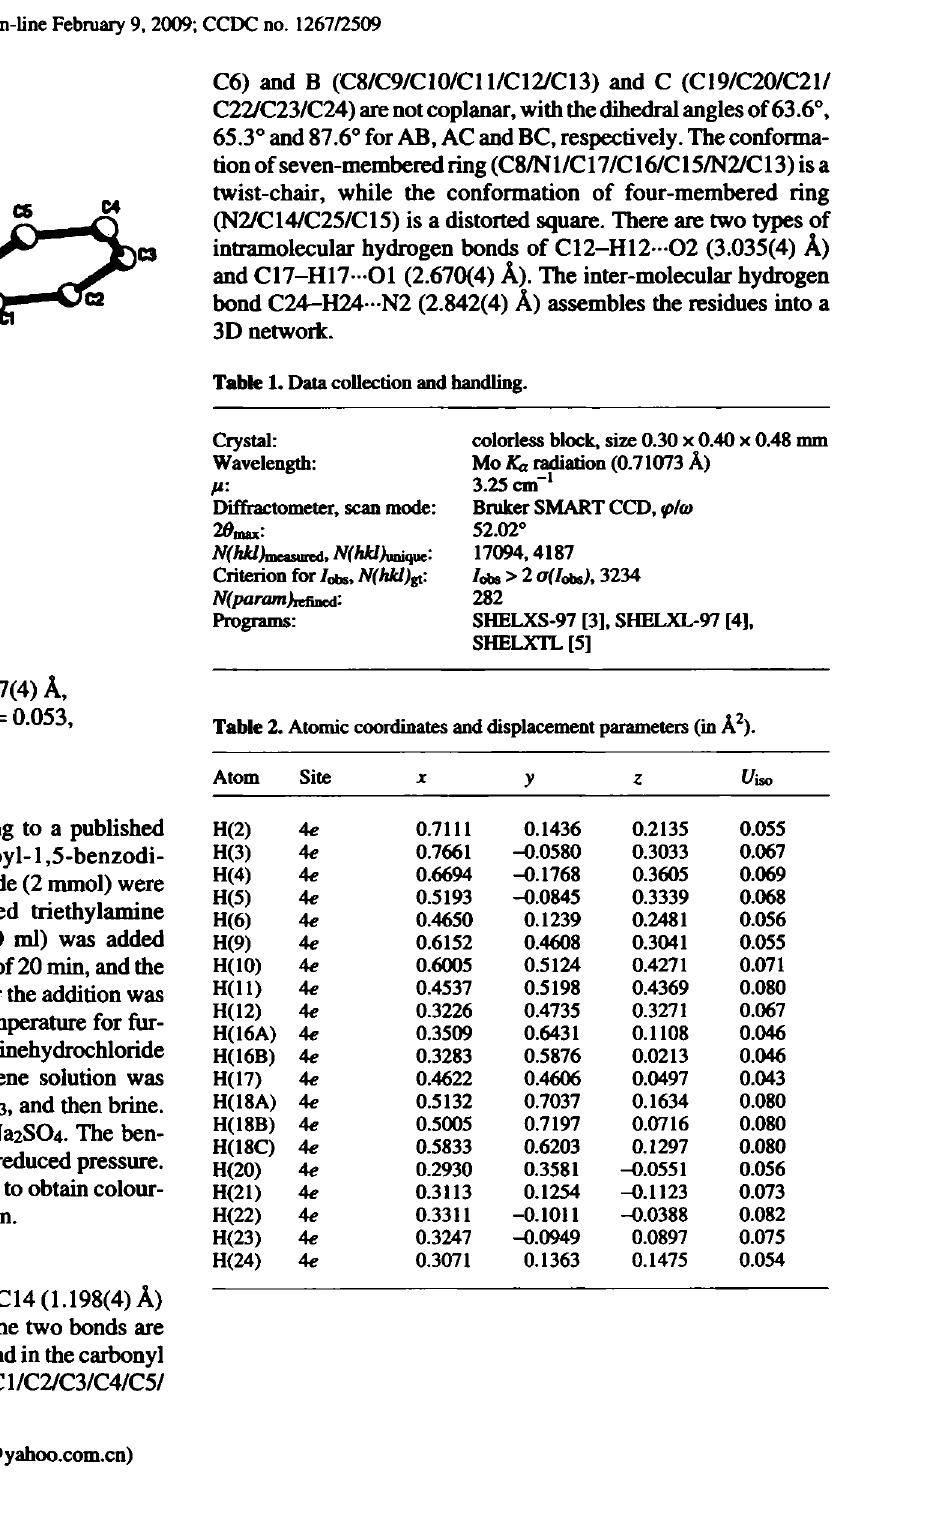
Table 1. Data collection and handling.